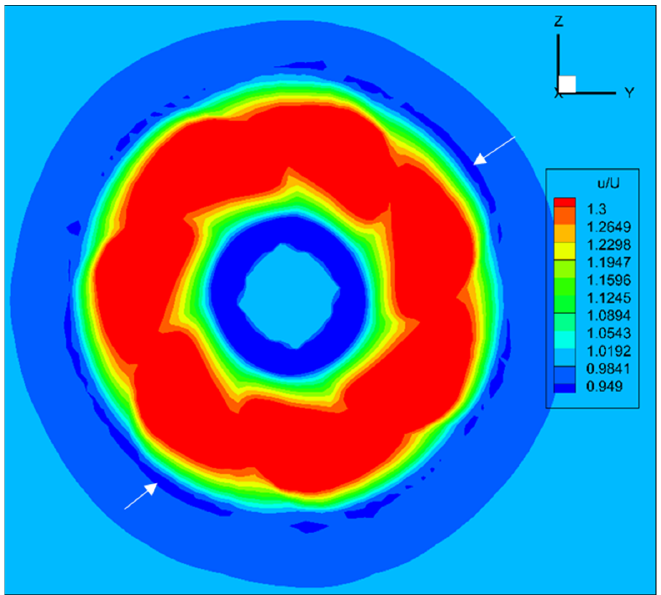
Figure 14. E1619 axial velocity distribution at x = 0.17 R behind the propeller for the rotating blade model. The propeller center is at x = 0. The arrow points out the low-velocity region outside blade tip.